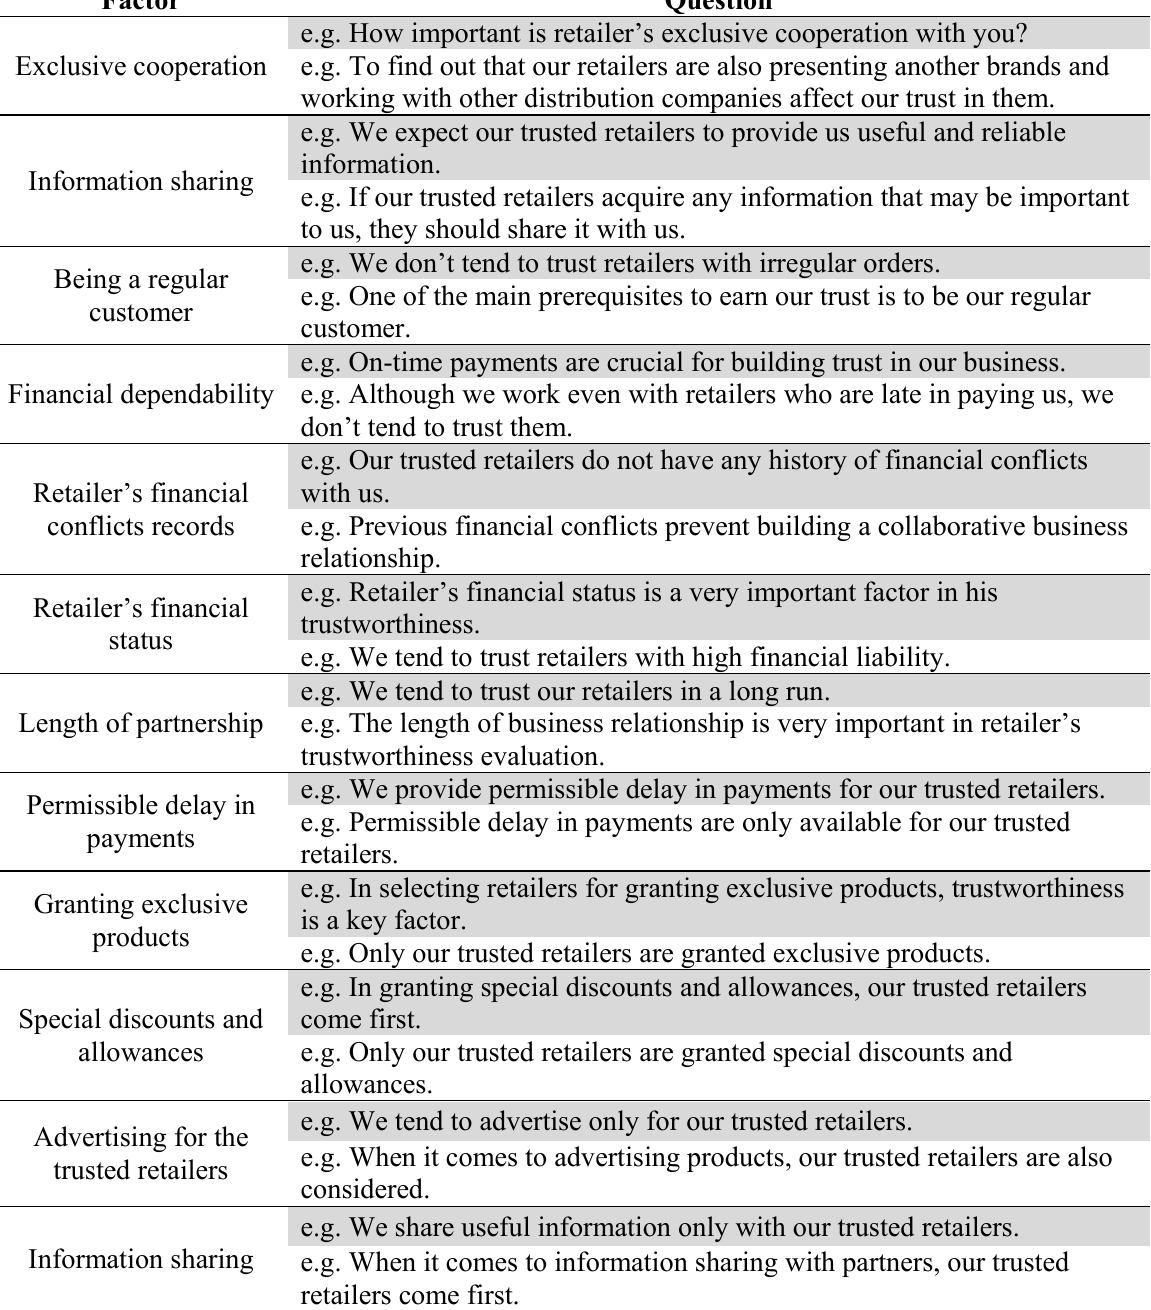
Table A1 The developed questionnaire for performance evaluation of distributors’ trust in retailers Factor Exclusive